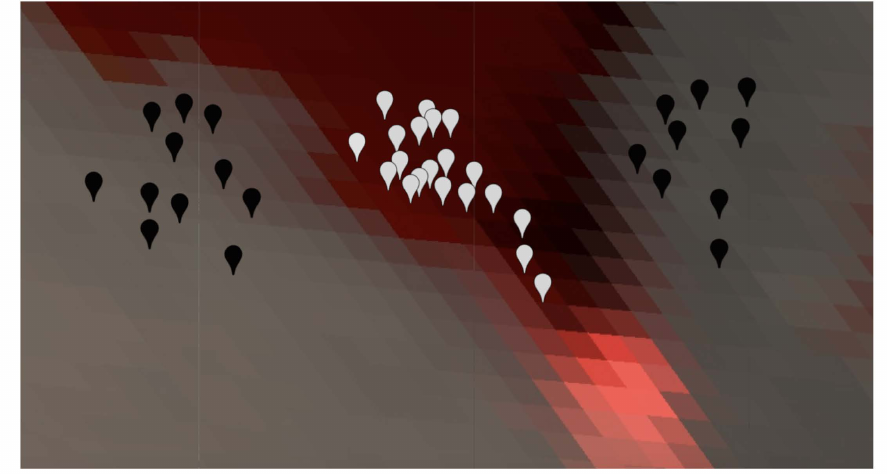
Figure 5. Sampling of Smoke/Cloud and Non-Smoke/Cloud Regions, Black Pins represent Non-Smoke/Cloud Regions and White Pins represent Smoke and